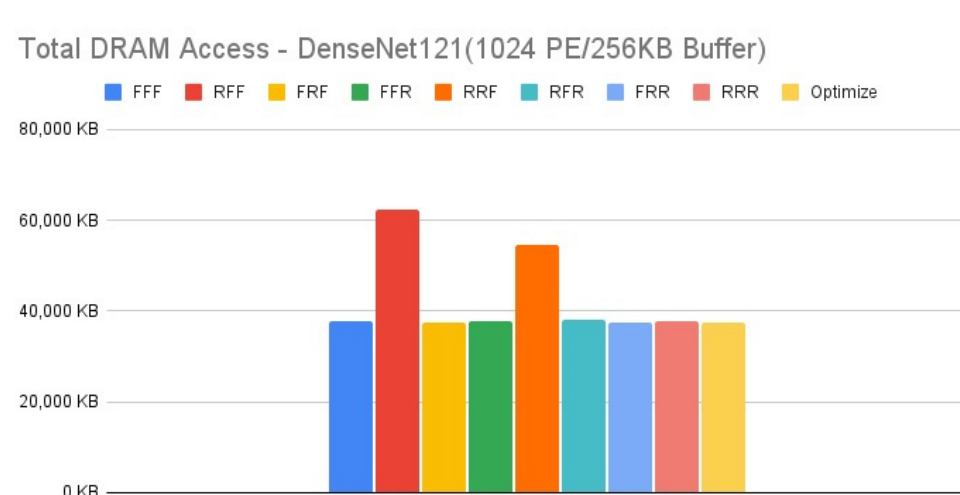
Figure 16. Total DRAM access—DenseNet121 (1024 PE/256 KB Buffer).